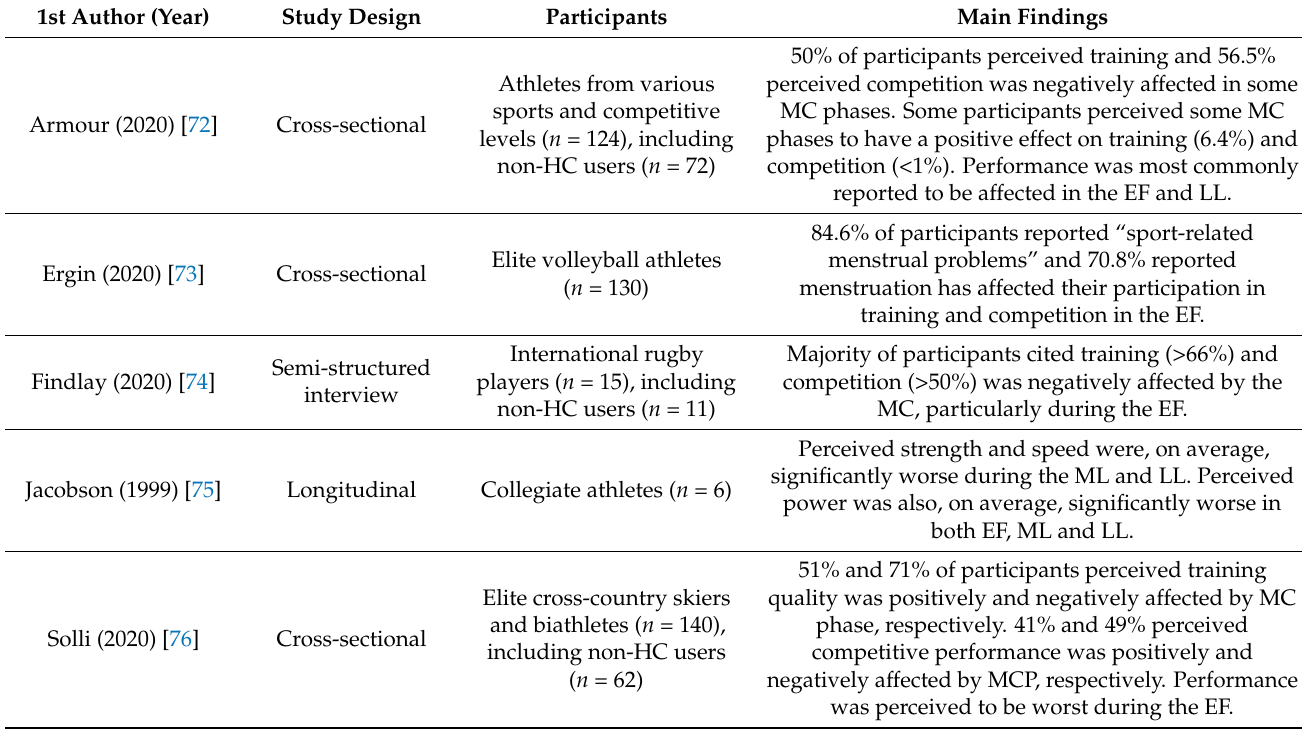
Table 1. Details and findings of studies on the effect of the menstrual cycle on perceived performance in